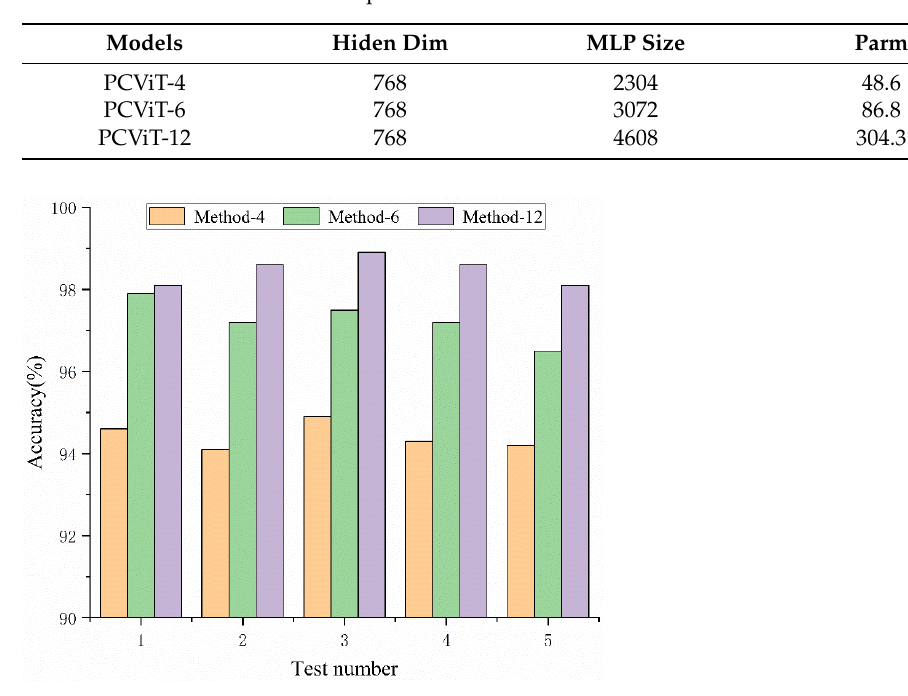
Table 4. Number of three network parameters.